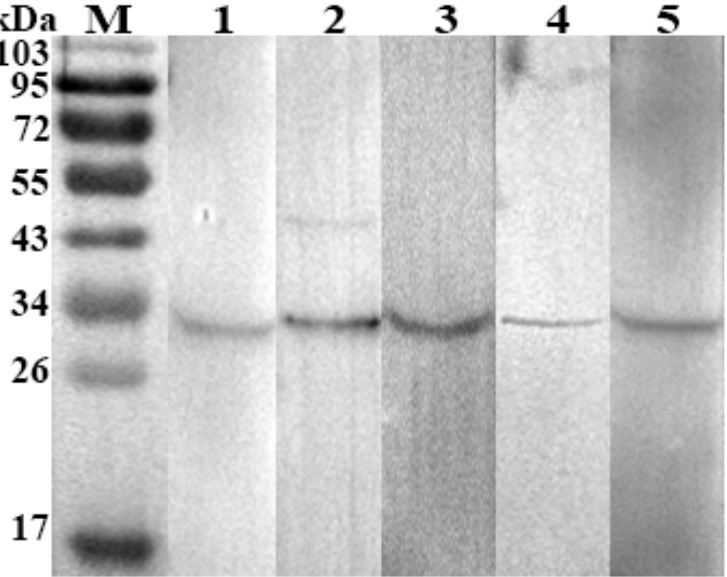
Figure 4. Western blot analyses of the goat serum samples that scored false negative in the ELISA-rHc-HCA59. M: standard protein pre stain molecular weight marker; Lanes 1–5: Serum samples with discrepant ELISA results. Specific antibodies against rHc-HCA59 were detected in all goats’ sera.